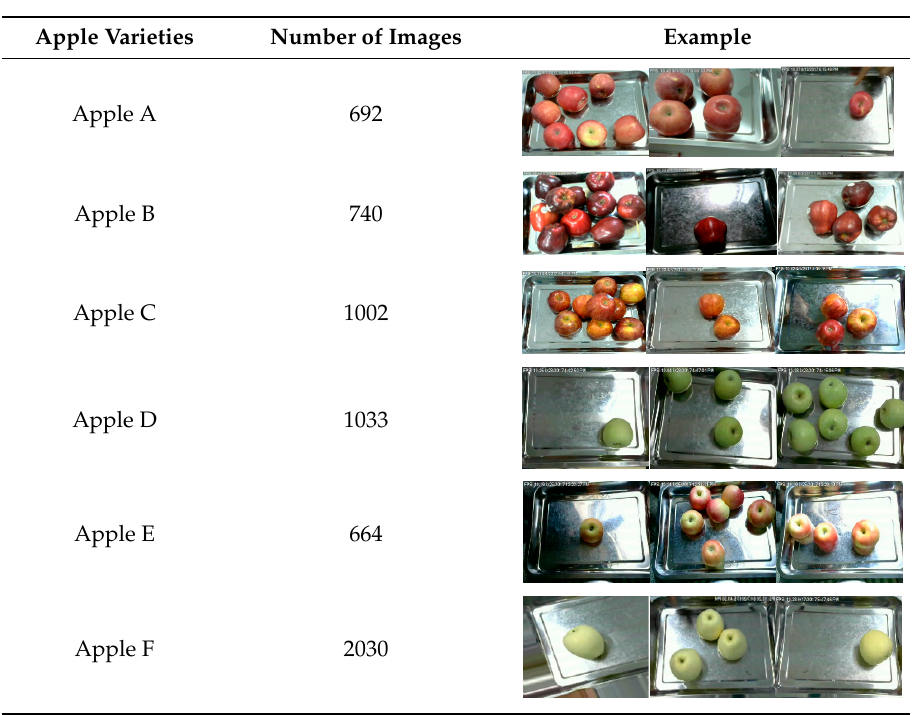
Table 2. Number of images in the variety class of apples.